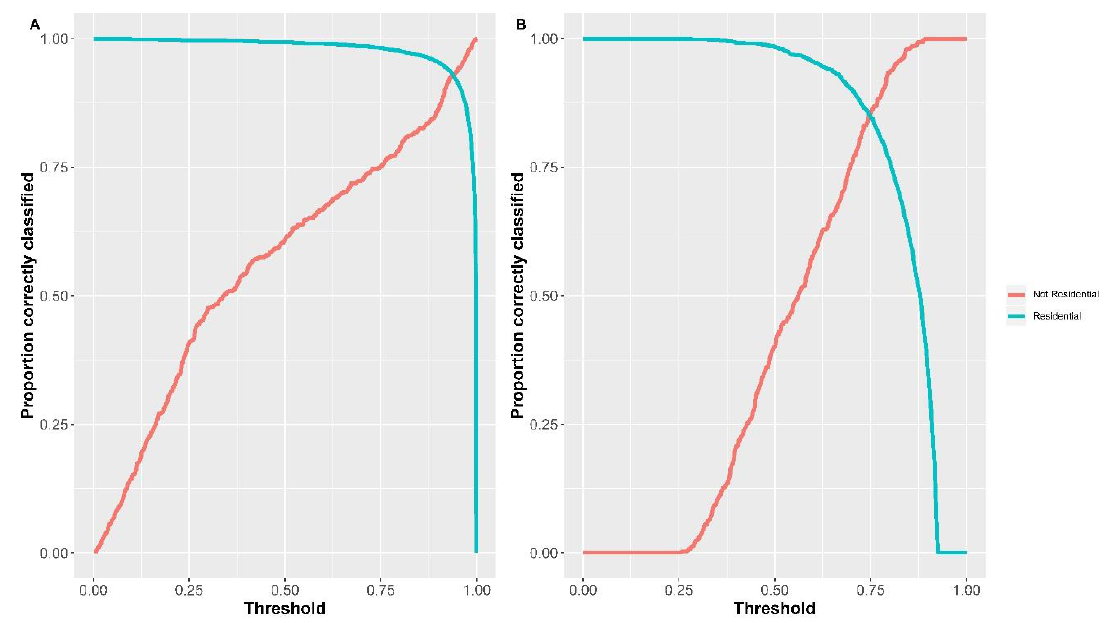
Figure 4. Classification performance of the building classification superlearner model using different cut-off thresholds, for ( A ) the Democratic Republic of the Congo and ( B ) Nigeria. Using the test data, the superlearner models achieve an AUC value of 0.98 in COD and 0.93 in